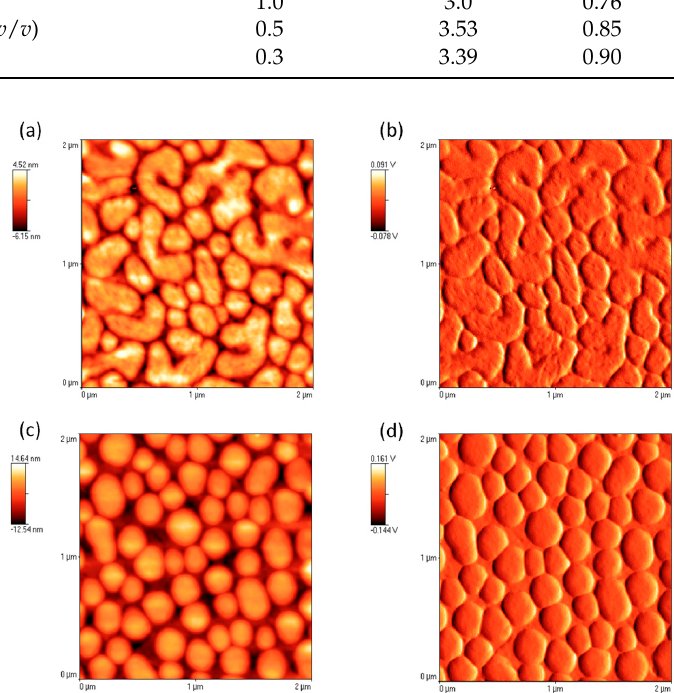
Figure 4. Surface topographic AFM images (2 μ m × 2 μ m) of M1 :PC 71 BM blend (40:60) films cast from 2% (w/v) chlorobenzene solution with ( a ) DIO (0.2%, v/v) and ( c ) CN (0.5%, v/v), respectively. ( b ), ( d ) Phase images corresponding to ( a ) and ( c ).